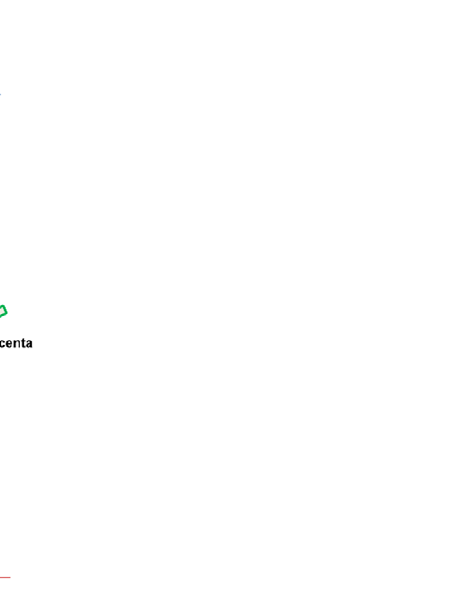
Figure 1. Maintenance and formation of measles-specific antibodies and memory B cells in mother and child. (A) In the non-infected mother, a normal number of memory B cells produce a protective level of measles specific antibodies, which are transmitted to the child via the placental barrier. In addition, the child will respond to measles vaccination by producing memory B cells and specific antibodies. (B) The HIV-1- infected mother loses a large number of memory B cells as a result of pathogenic mechanisms linked to HIV-1 infection; this phenomenon leads to a reduced amount of measles-specific antibodies in the mother and a low level of transmitted antibodies to the child. The HIV-1-exposed, non-infected child, is, however, competent to respond to measles vaccination by generating protective levels of measles antibodies and measles-specific memory B cells. (C) As a consequence of HIV-1 infection, both the HIV-1-infected mother and child lose measles-specific memory B cells formed upon measles natural infection or vaccination. This leads to a low, non-protective level of measles antibodies in the mother, a low level of antibodies transmitted through the placental barrier to the child, and a low, non-protective level of measles-specific antibodies produced from the infected child upon